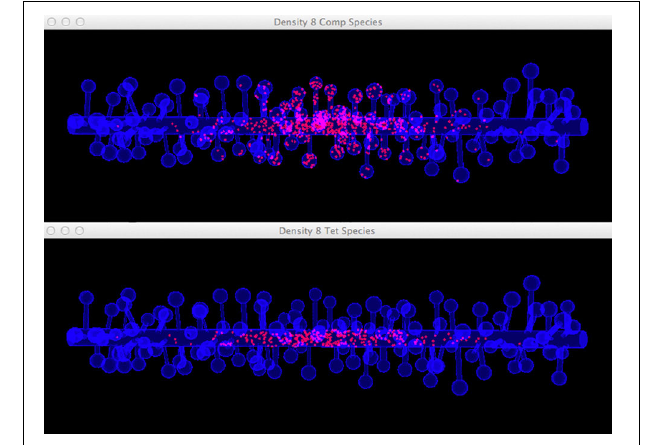
FIGURE 10 | Comparison between the visualization of Top: compartment species component and Bottom: tetrahedron species component in anomalous diffusion simulation with the 8/ µ m spine density mesh. Molecules that are trapped in spines are displayed in the compartment species component, but are filtered by the tetrahedron species component. The latter produces a more clear view of molecule distribution in the shaft cylinder.